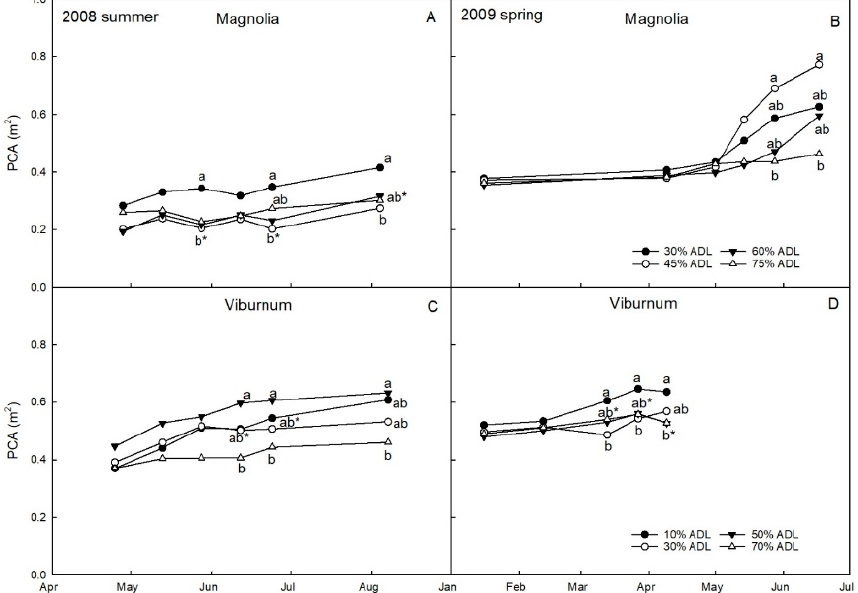
Figure 1. Projected crown area (PCA) increase during the summer and spring study periods for Southern magnolia ( Magnolia grandiflora; n = 4) and sweet viburnum ( Viburnum odoratissiumum; n = 3) growing in lysimeter containers and subjected to four levels of allowable soil water depletion levels (ADL). ( A , B ), Projected Crown Area (PCA) of magnolia during the 2008 summer and 2009 spring; ( C , D ) PCA of viburnum during the 2008 summer and 2009 spring. Dates with mean separation letters (a, b, ab) are significantly different at p < 0.05. Letters with an asterisk indicate adjacent date points that are not significantly different.